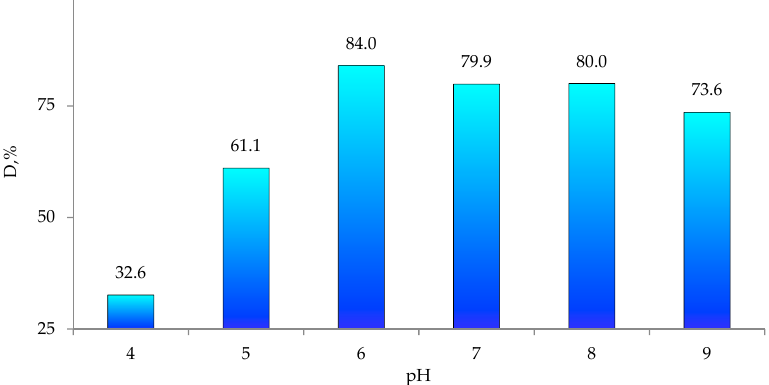
Figure 6. Variations in Cmz degradation degree (D, %) as a function of pH for ZnO@PET composite membrane.